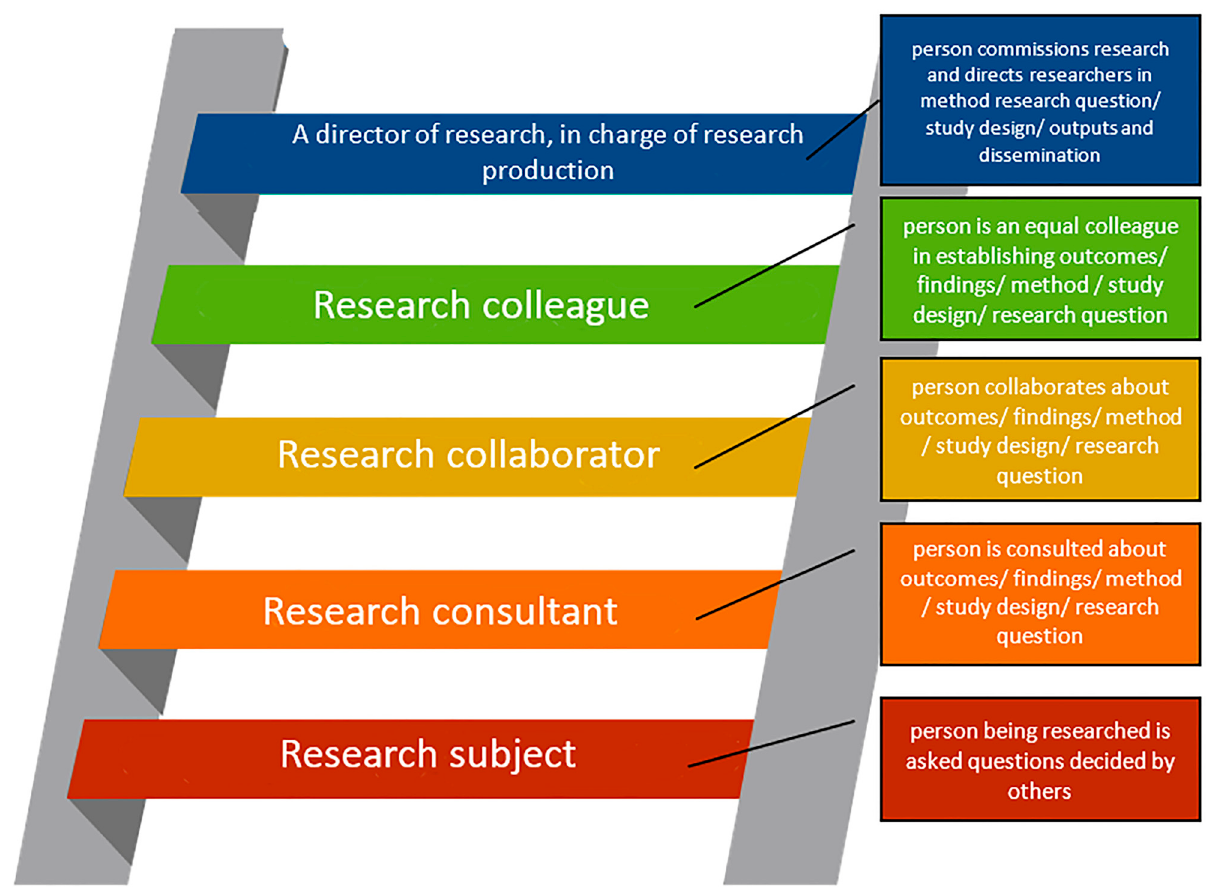
Figure 3. Ladder of research inclusion.